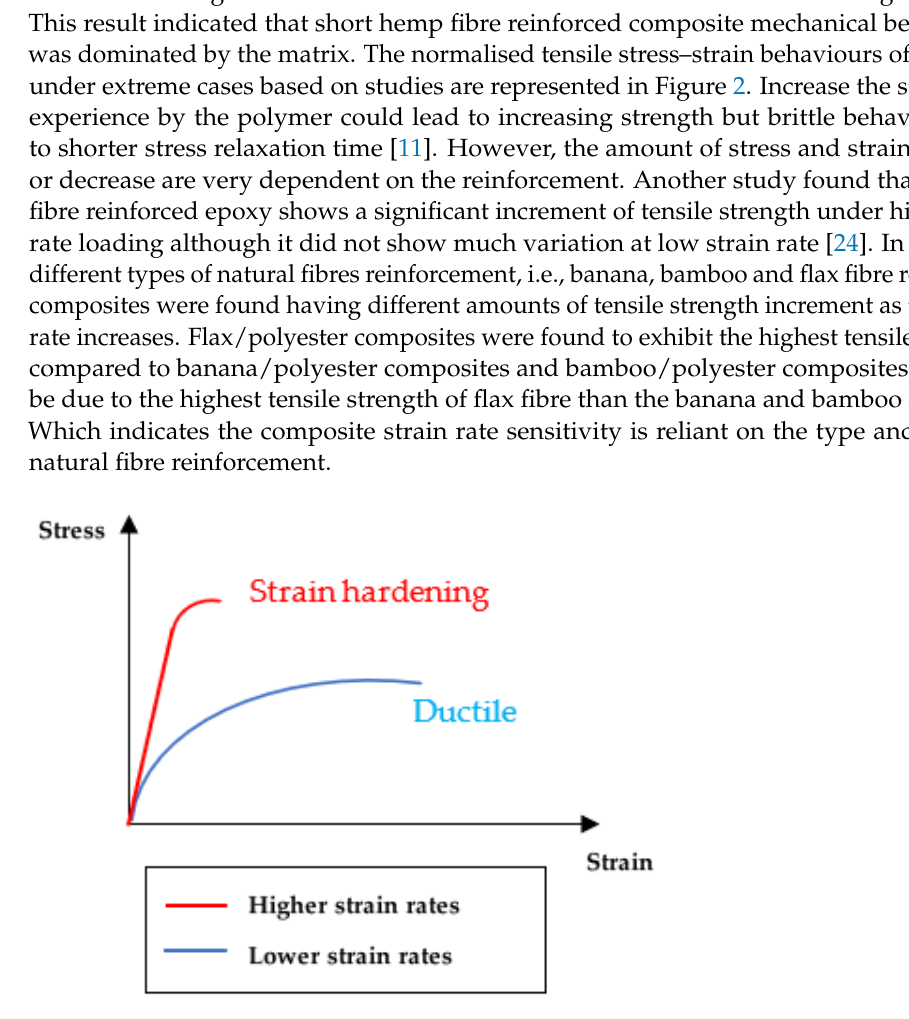
Figure 2. Normalised tensile stress–strain responses as the strain rate increased.